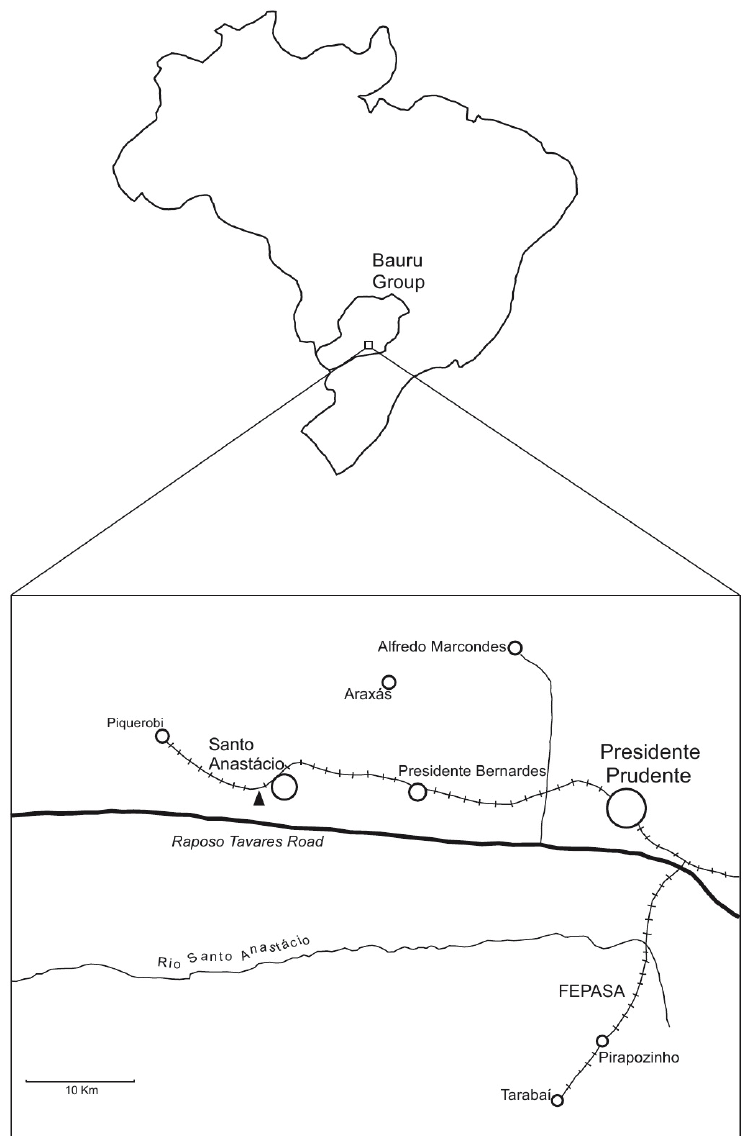
Figure 3 - Geographical situation of the fossil locality where the coprolites were recovered; Fossil locality